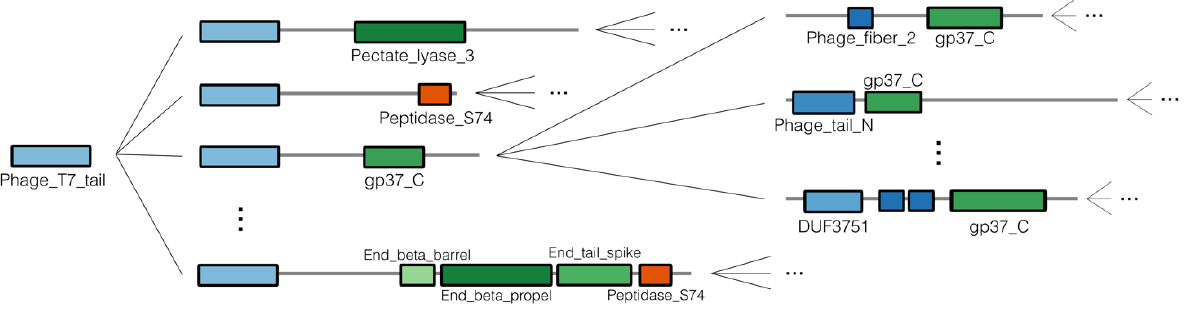
Figure 2. Visualization of the iterative manual search of RBP-related protein domains in the Pfam database, starting from the Phage_T7_tail domain. The iterative procedure entailed alternately identifying domains at the N- or C-terminus that were linked to the domains identified in the previous iteration of the manual search.